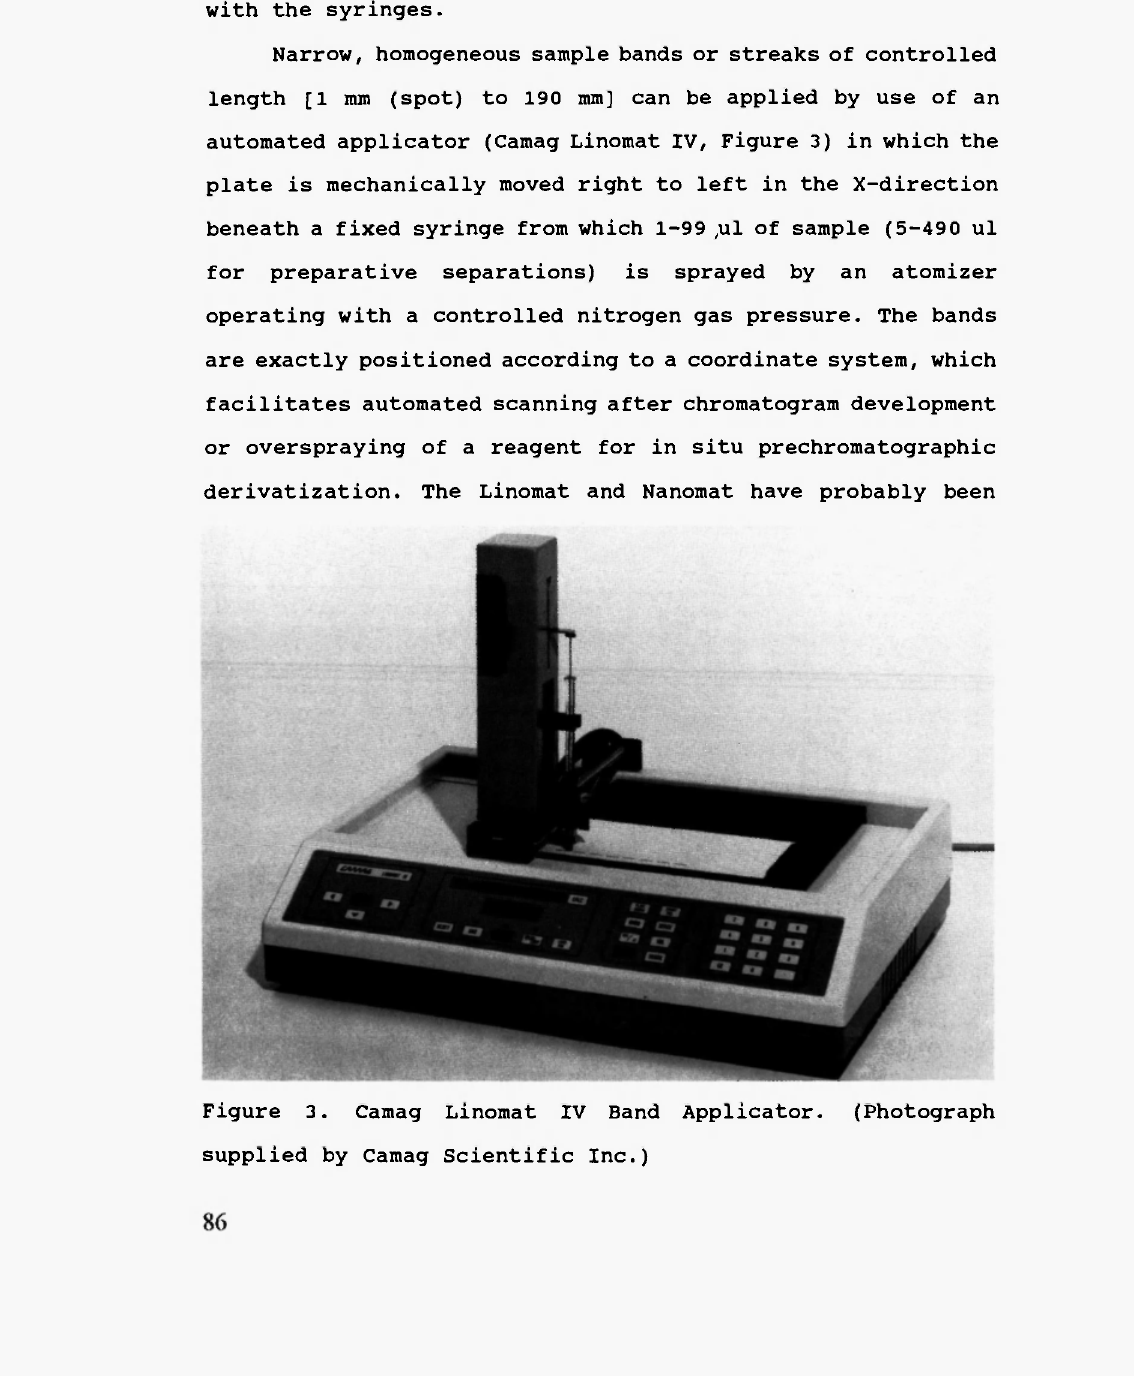
Figure 3. Camag Linomat IV Band Applicator.